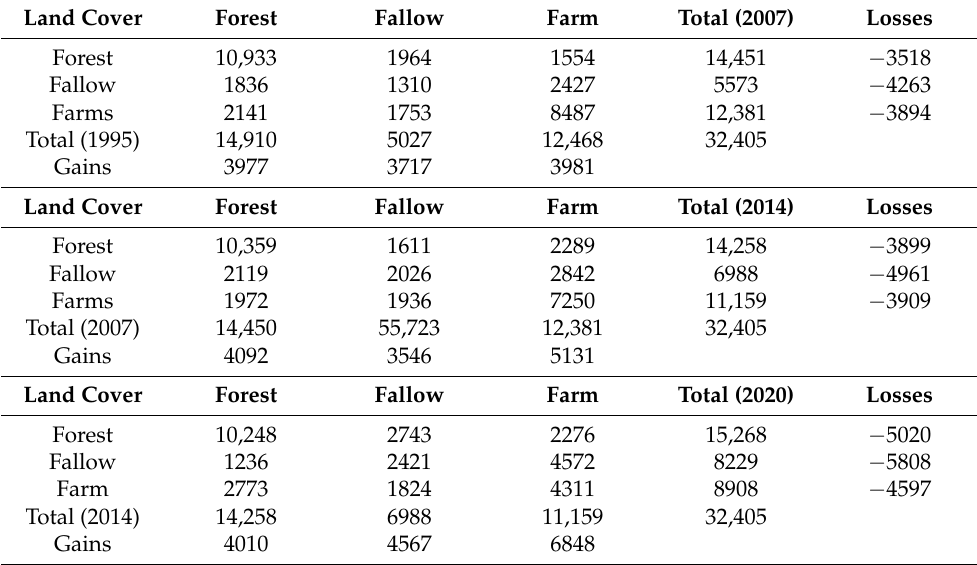
Table 6. Land use change (ha) between 1995 and 2020. Bold numbers indicate no change in land cover during the assessment